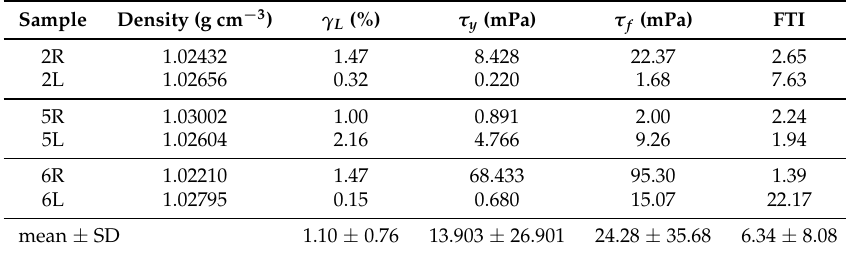
Figure 4. Determining the yield point by finding the limit of the linear-elastic (LE) region. When a straight line is fitted to the linear region of the stress-strain curve, where the Law of Elasticity applies, the final point before the yield exceeds the line corresponds to the end of the LVE shown in Figure 3. Table 5. Limit of LVE region ( γ L ), yield point ( τ y ), flow point ( τ f ), and flow transition index (FTI) values for six